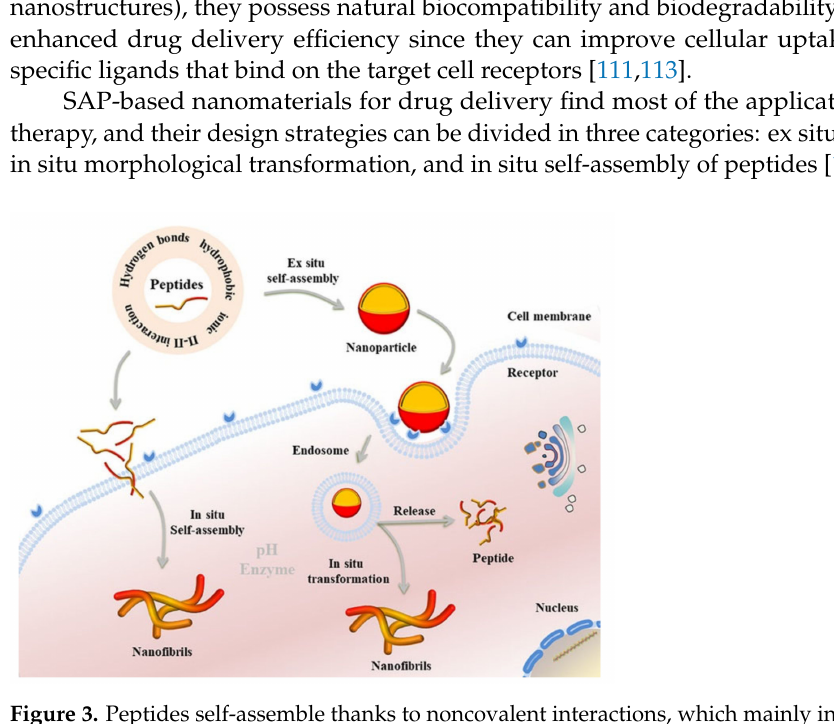
Figure 3. Peptides self-assemble thanks to noncovalent interactions, which mainly include hydrogen bonds, hydrophobic, ionic, and π − π interactions. Self-assembly nanomaterials can be designed to be specifically constructed ex situ, in situ, or to underlie an in situ morphological transformation. Figure reproduced from